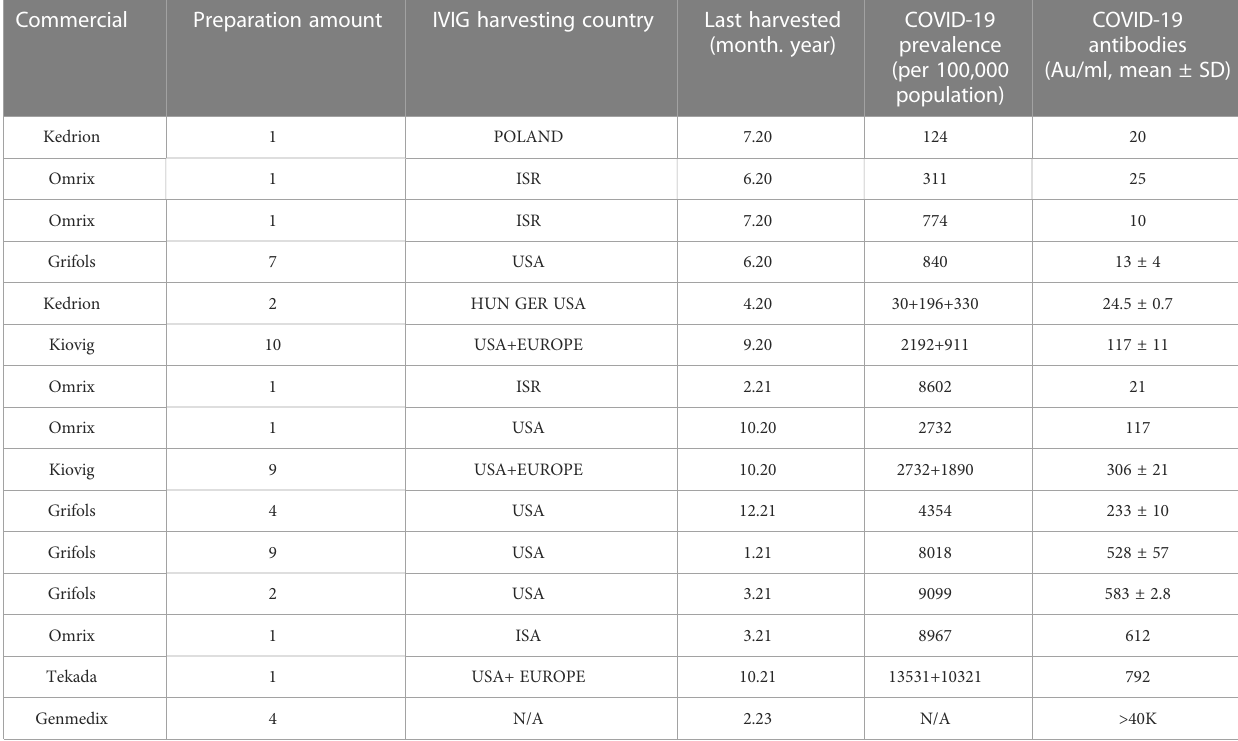
TABLE 2 IVIG preparation harvesting details and SARS-CoV-2 antibodies titer levels found in preparation. (COVID-10 prevalence from https:// covid19.who.int/).